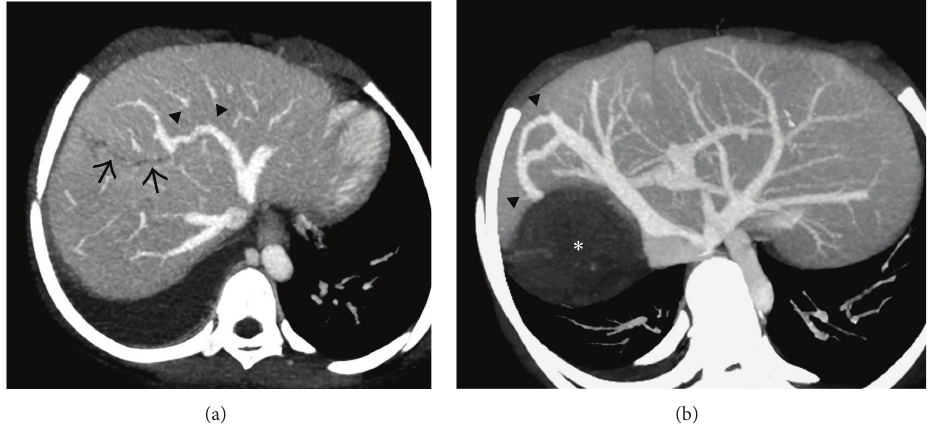
Figure 27: Secondary BCS in two different patients. (a) Axial maximum-intensity-projection (MIP) CECT image in a patient with past history of blunt trauma to the abdomen demonstrating a liver laceration (arrows) which had caused thrombosis of the middle hepatic vein with resultant comma-shaped intrahepatic venovenous collateral (arrowheads) between the left hepatic vein and the remnant middle hepatic vein. (b) Axial MIP image from the CECT scan of a young woman with hydatid cyst of liver (asterisk) causing thrombosis of the right hepatic vein and formation of intrahepatic collateral (arrowheads) between the middle and right hepatic